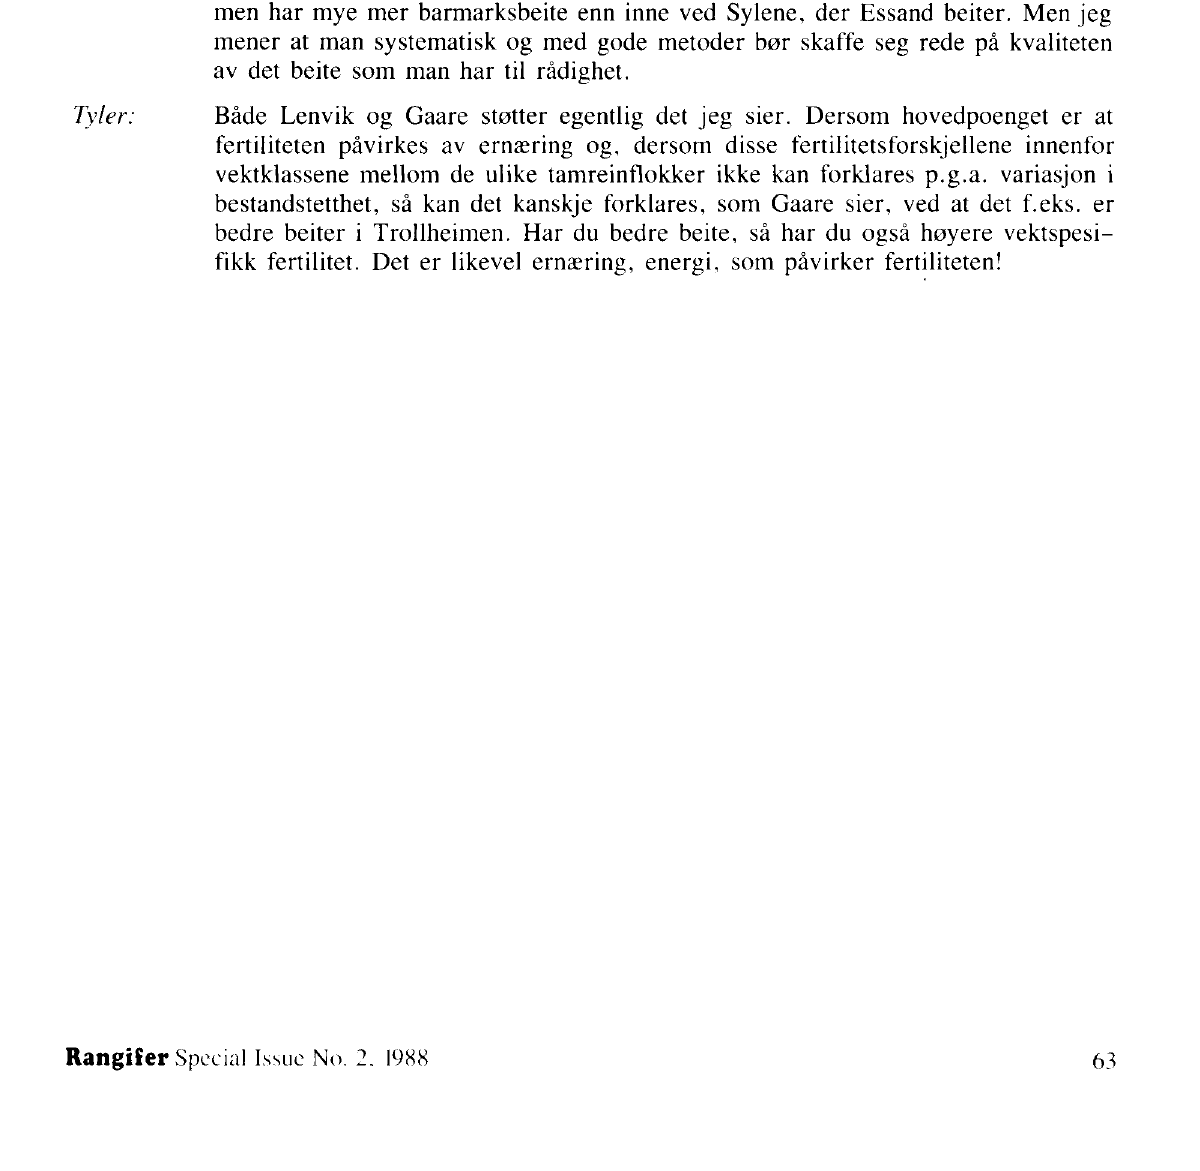
«umodne» vektklassene av hunndyr, kalver og ungsimler) 2. Isolere simlekalvene fra bukkeflokken gjennom brunsten. 3. Provosere fram kalvekasting hos simlekalvene etter